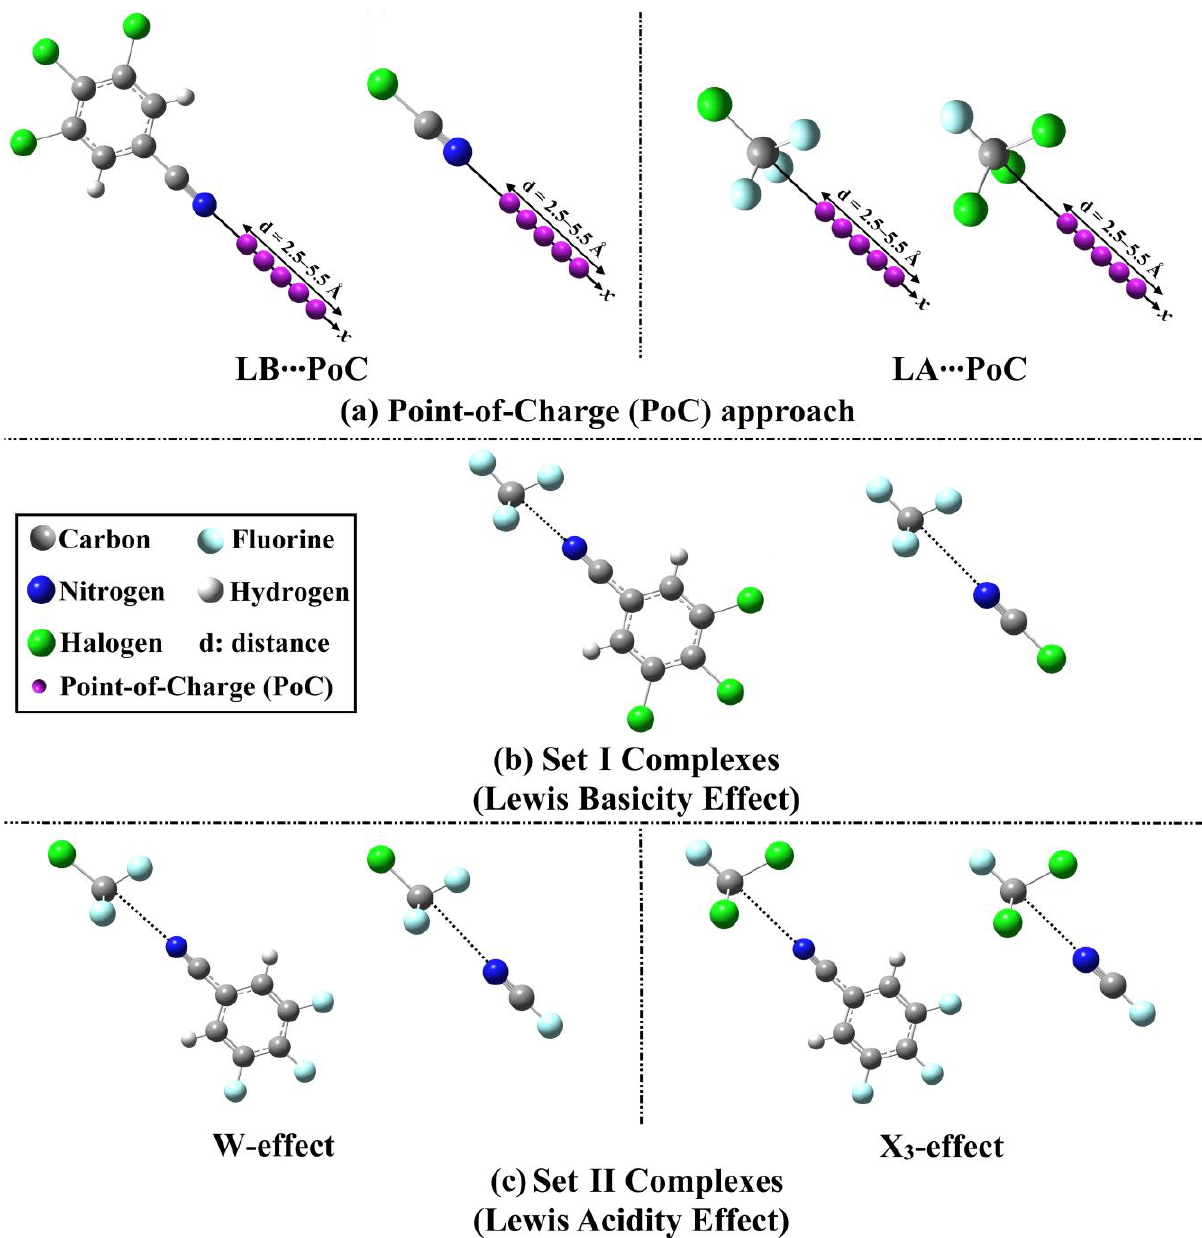
Figure 1. Illustrative representation for ( a ) the PoC calculations for Lewis base (LB) ∙∙∙ and Lewis acid (LA)∙∙∙PoC systems , ( b ) Set I Complexes (F-C-F 3 ∙∙∙NC -C 6 H 2 -X 3 /∙∙∙NCX), and ( c ) Set II Complexes (W-C-F 3 ∙∙∙ and F -C-X 3 ∙∙∙NC -C 6 H 2 -F 3 /NCF).